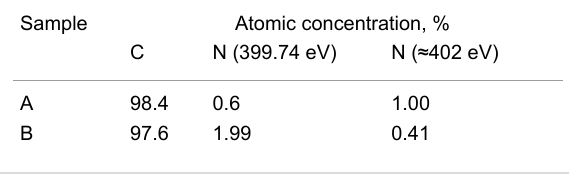
Table 1: Quantified surface atomic concentrations for samples A and B on SiO 2 /Si substrate as obtained from the XPS study.